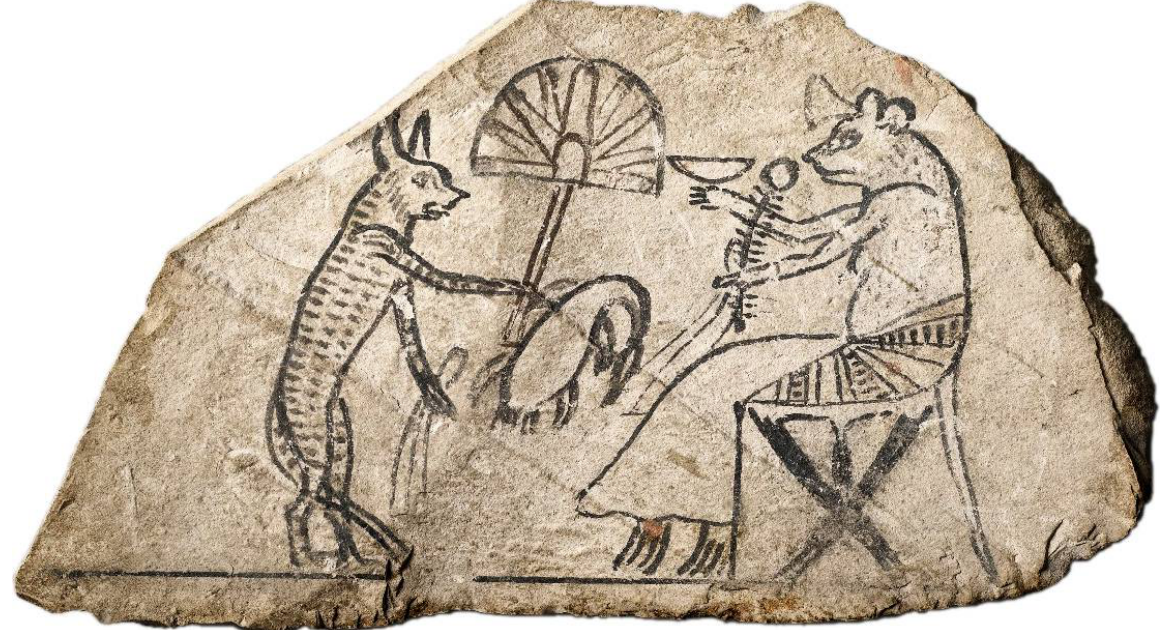
Figure 4. Cat serving seated mouse (Brooklyn Museum acc. no. 37.51E), limestone flake, findspot unknown (Egypt), Ramesside period (Photography by Gavin Ashworth, courtesy of the Brooklyn Museum, New York).